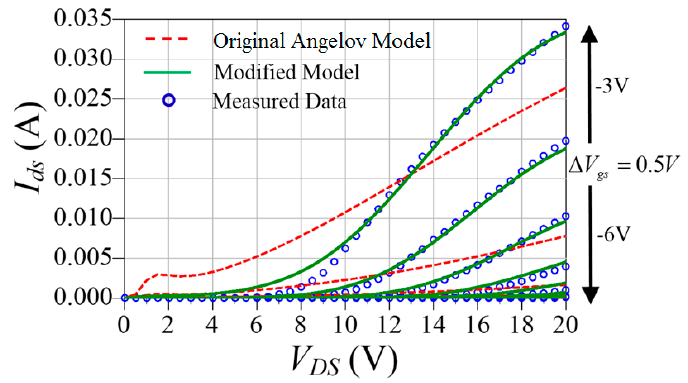
Figure 2. Comparison between simulated and measured results when V gs is close to pinch-off voltage.